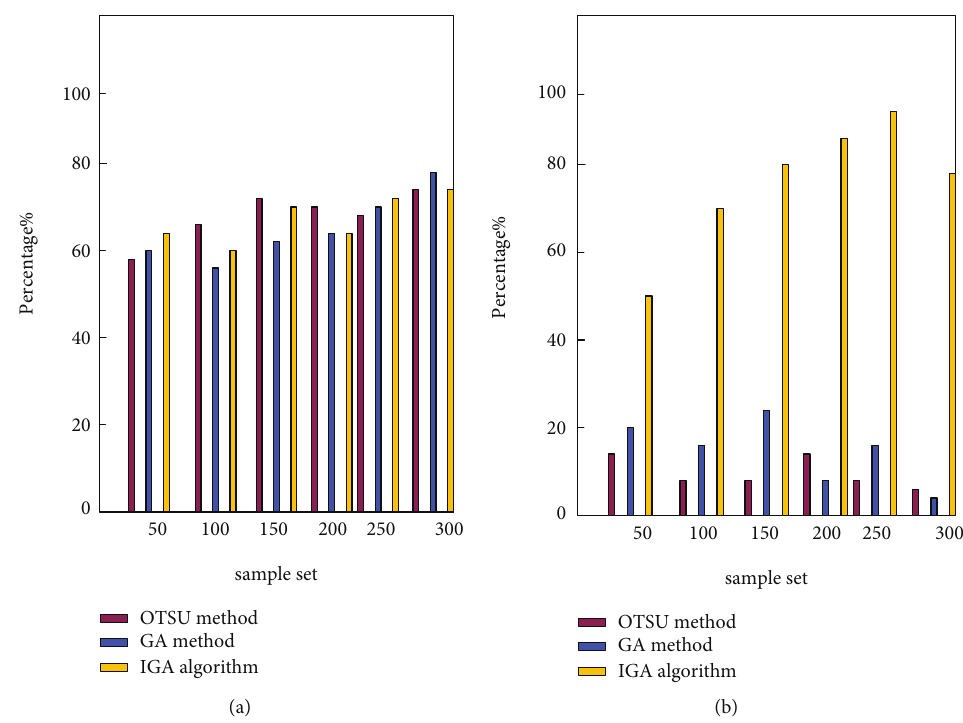
Figure 5: Comparison of the e ff ects of three methods for processing images. (a) Comparison of the e ff ects of the three methods for processing the contour of the image target. (b) Comparison of the e ff ects of the three methods for eliminating interference.